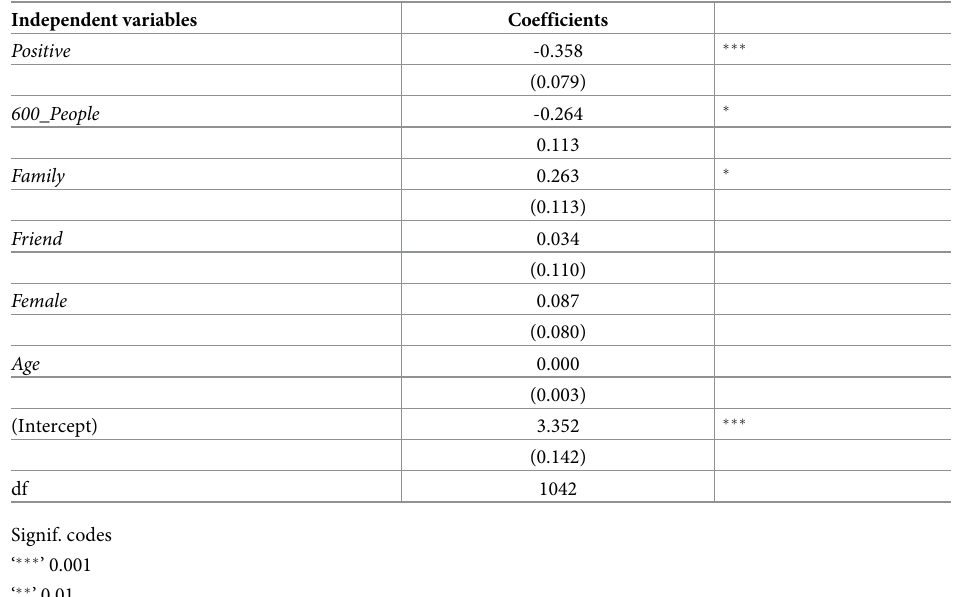
Table 5. Estimates for multiple regression model with 6 response categories.